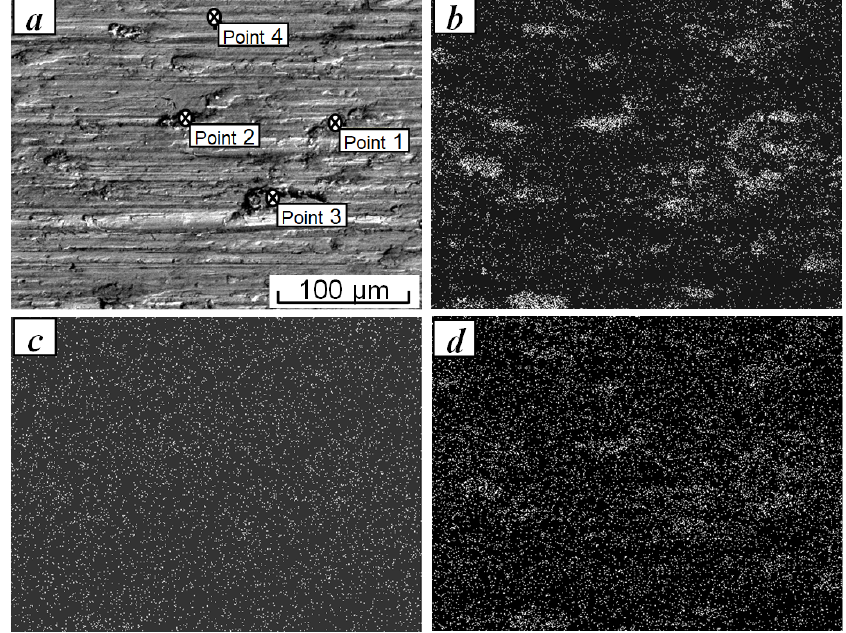
Figure 6. Structure of the friction track after 530 passes of the ECAP-ed Al-30Sn sample. ( a ) SEM image (SE); ( b ) aluminum distribution map (EDX); ( c ) tin distribution map (EDX); ( d ) oxygen distri- bution map (EDX); P = 1 MPa; V sl = 0.07 m/s; L = 1000